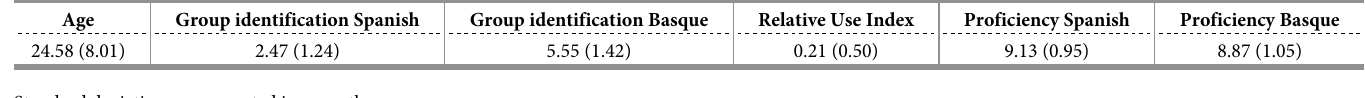
Table 1. Mean participants descriptive variables for Study1.